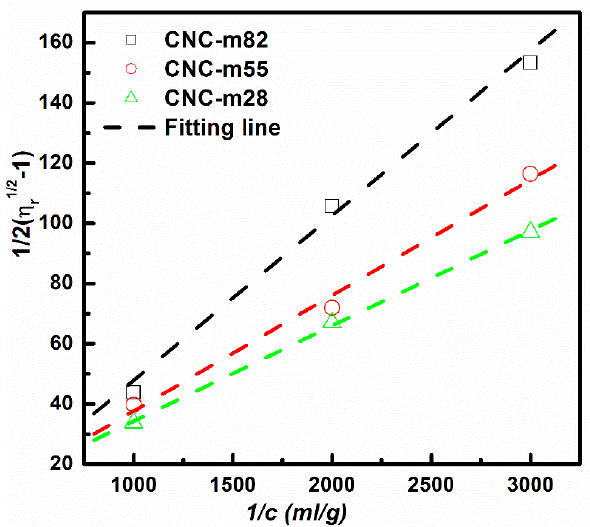
Figure 4. Fedors plots for CNC-A and CNC-B mixed suspensions with 1.0 mM NaCl.